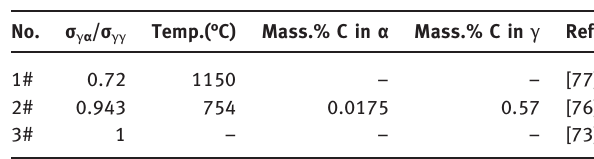
Table 3: Physical parameters used for the calculation of the grain boundary ferrite nucleation